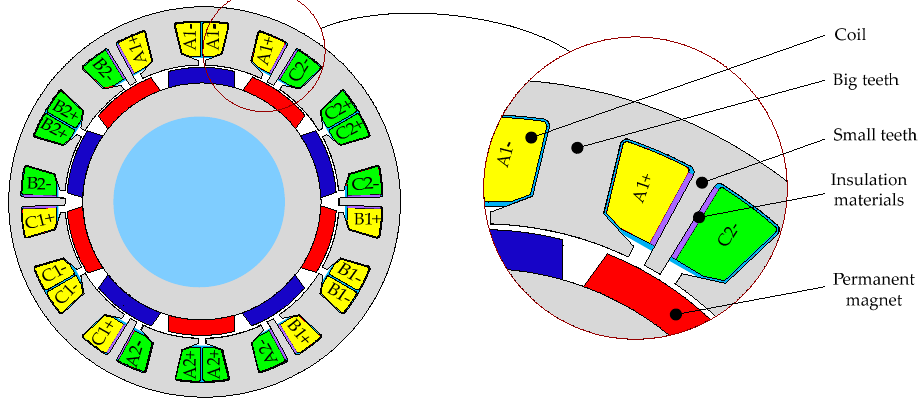
Figure 1. Cross-sectional view of the DRPMSM.